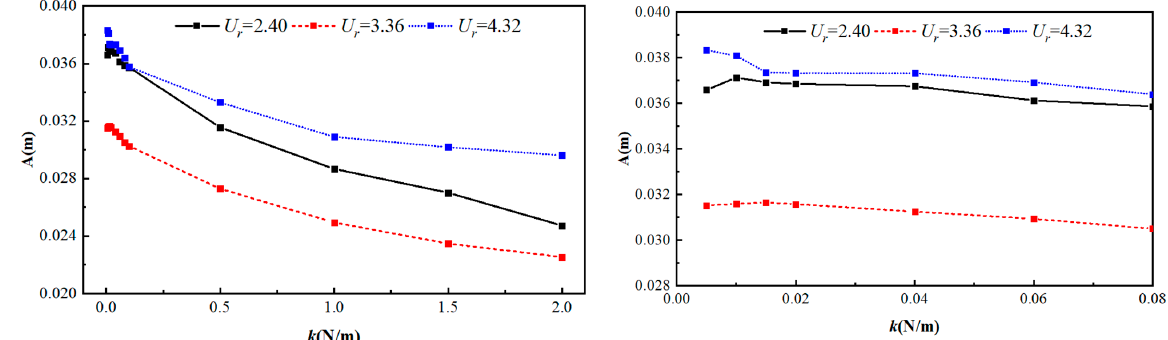
Figure 12. Vibration responses under different flow rates ( S/D = 0, T = 1.29 s, A W = 0.0375 m).